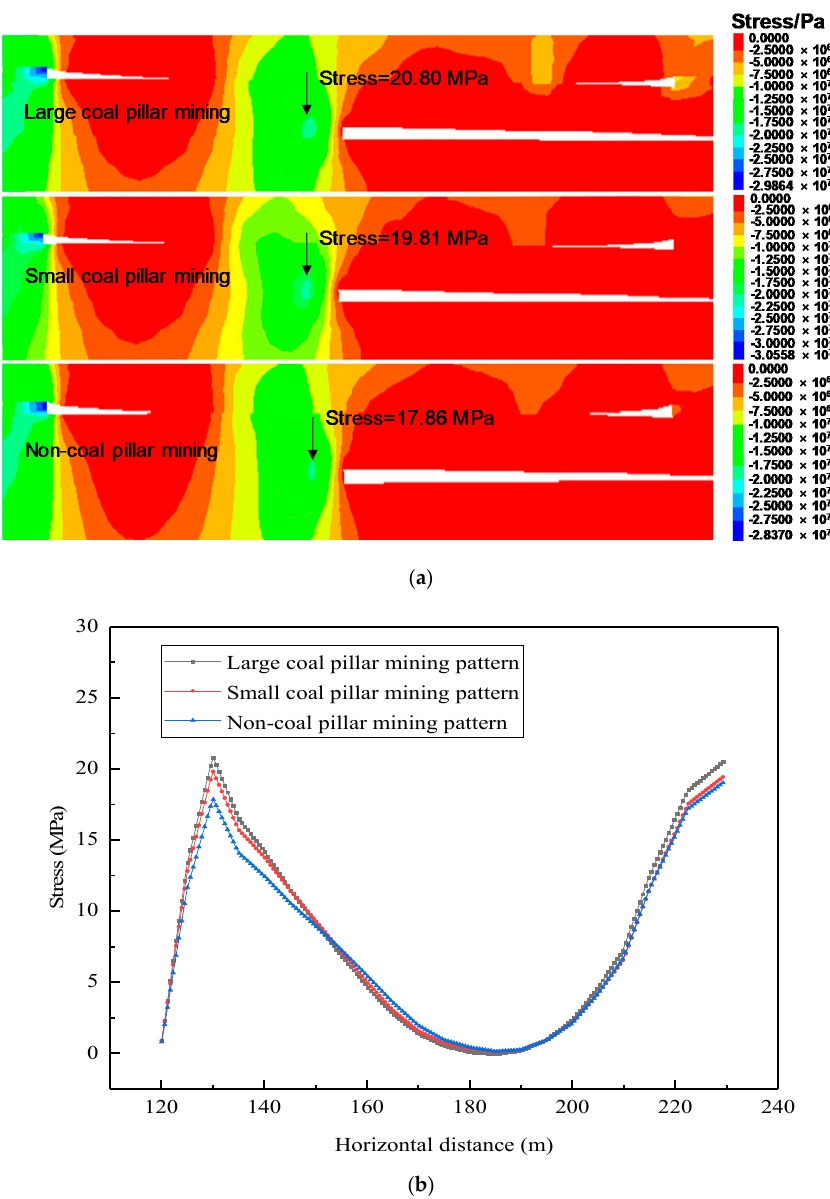
Figure 10. Vertical stress nephogram and stress distribution curve at the monitoring line 1 along the working face strike. ( a ) Vertical stress nephogram; ( b ) Stress distribution